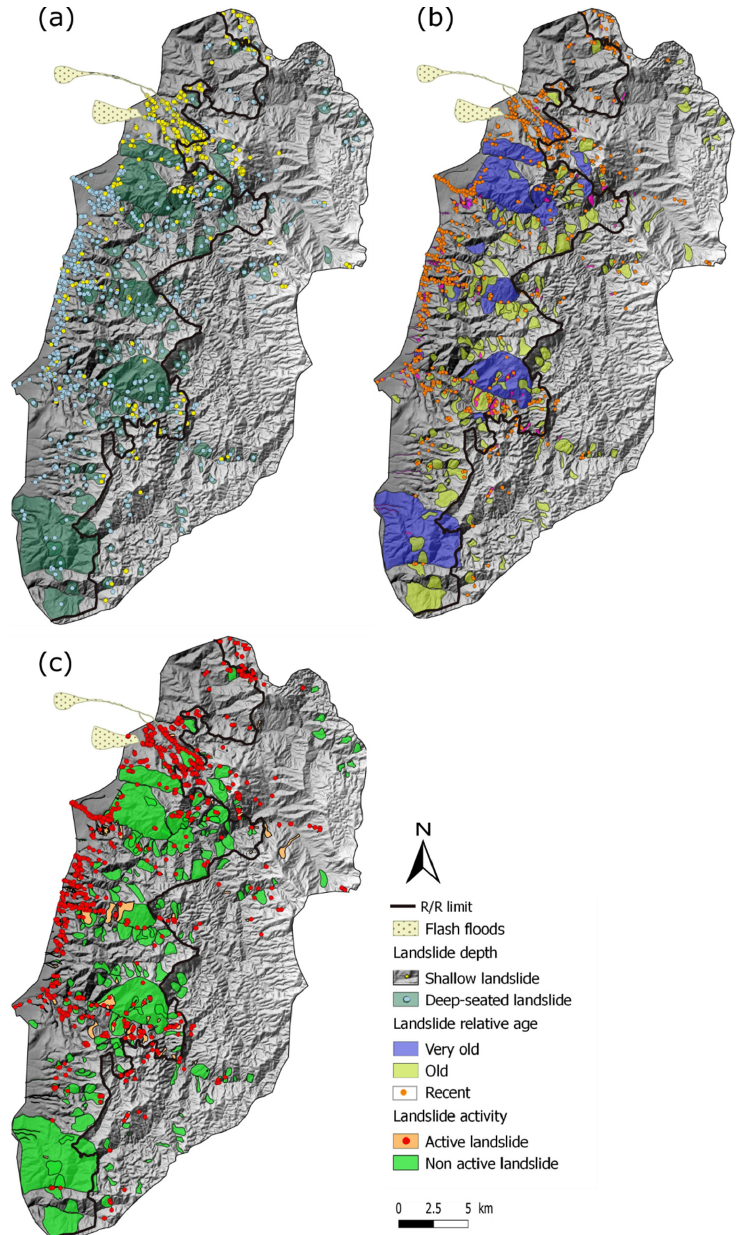
Figure 3. Mapped landslides classified by ( a ) depth, ( b ) relative age, and ( c ) level of activity. The hillshade is from the 10-m resolution DEM (Table 1). The landslides <14,000 m 2 are represented with a dot so that they are visible at the scale of the maps.